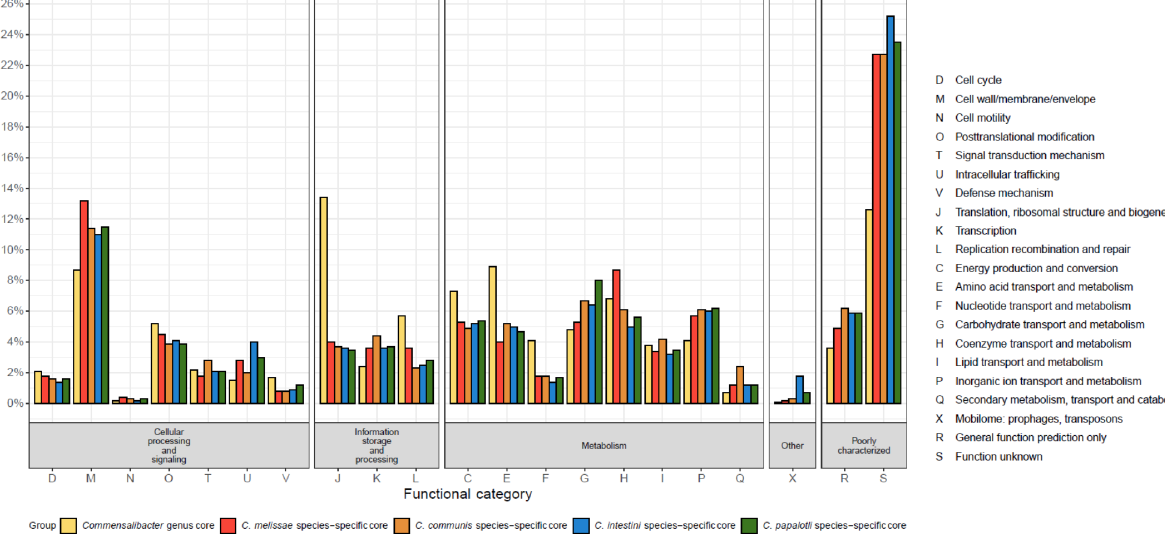
Fig. 3 Distribution of gene clusters over COG categories of the Commensalibacter genus core and Commensalibacter species core genomes. Percentages of gene clusters per group are presented